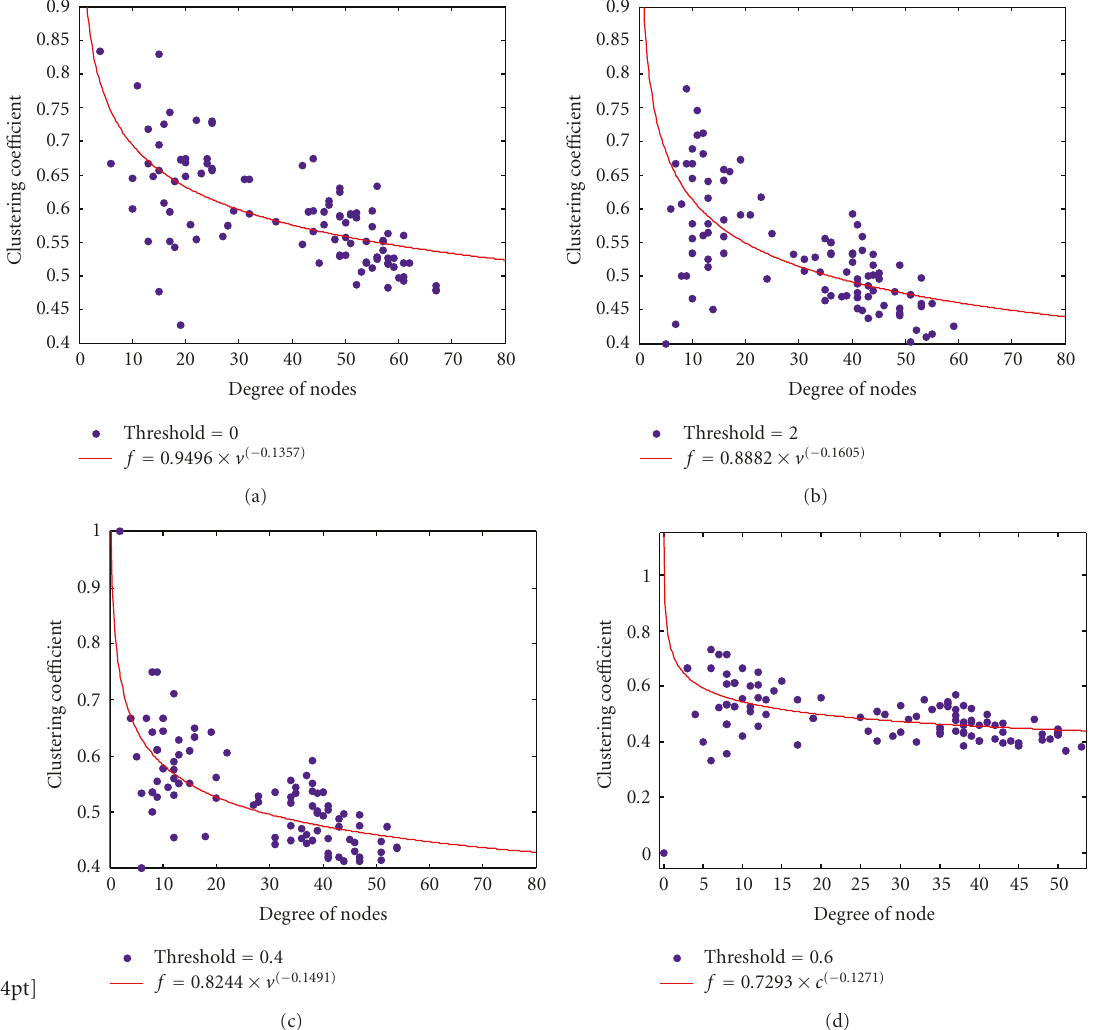
Figure 16: Power law for distribution of clustering coe ffi cient versus degree of nodes: dataset A.